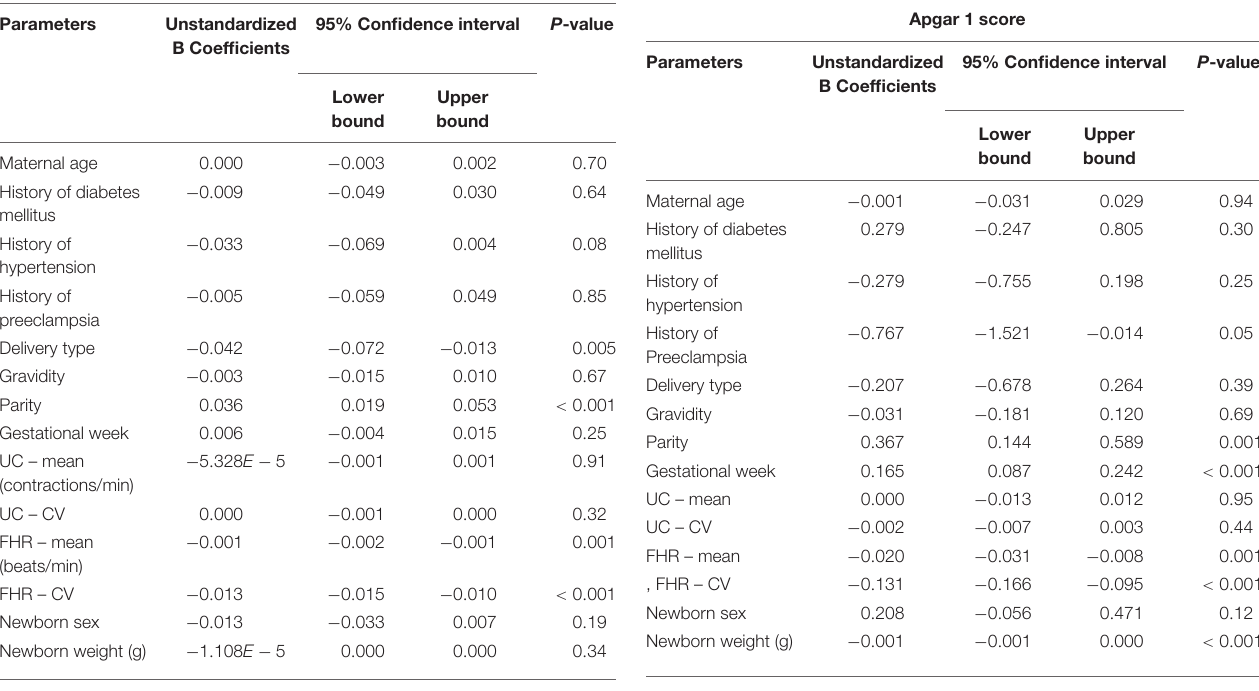
TABLE 5 | Association between maternal and newborn parameters and Apgar 5 score (5 min after